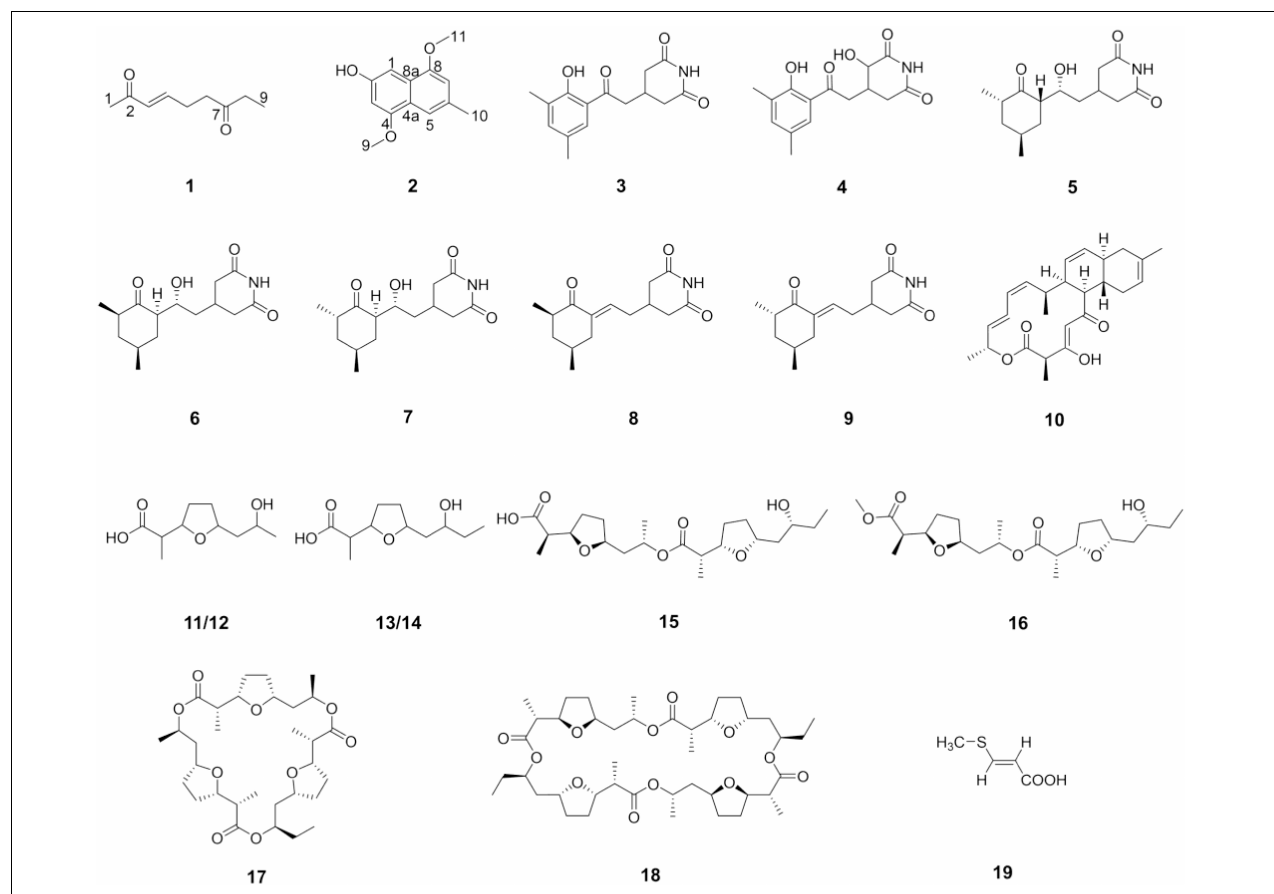
FIGURE 4 | Structures of the compounds isolated from strain YINM00001.